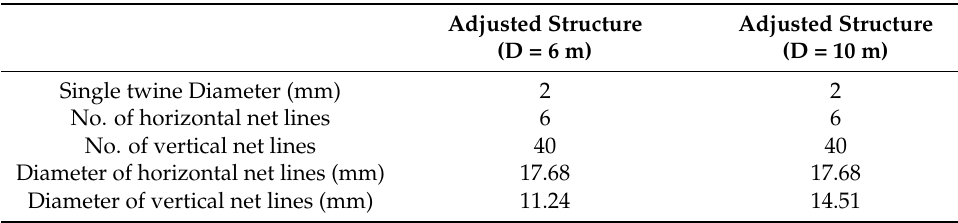
Table 1. Parameters of the truss